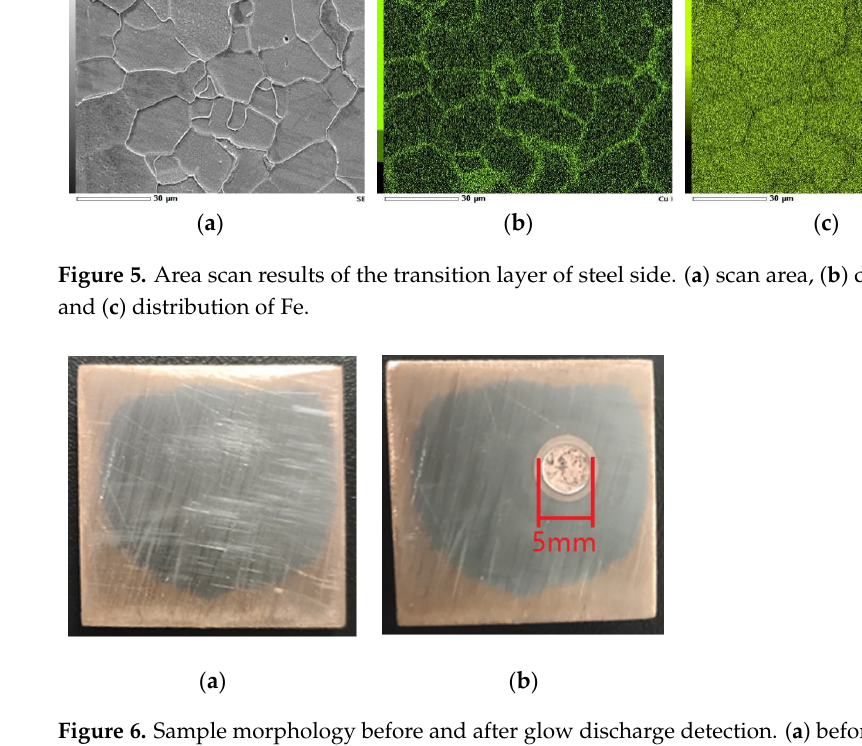
Figure 6. Sample morphology before and after glow discharge detection. ( a ) before and ( b ) after.